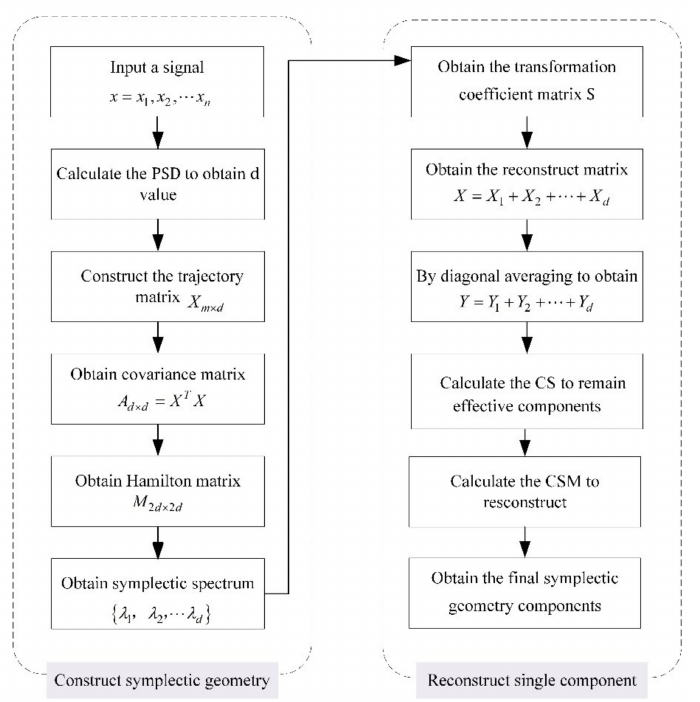
Figure 1. Flowchart of the symplectic geometric mode decomposition-cosine similarity (SGMD- CS)